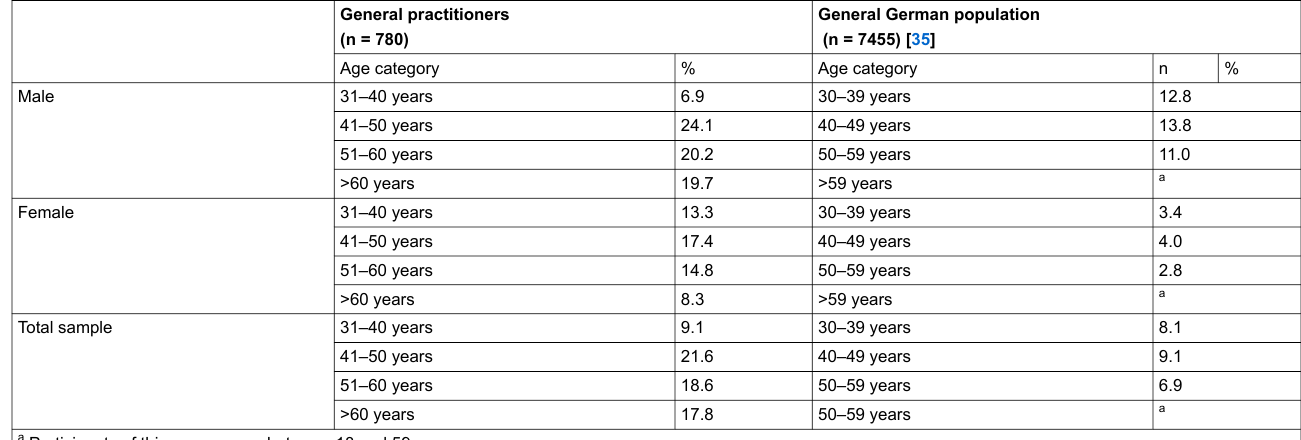
Table 5: Descriptive comparison of the relative frequency of lifetime alcohol use disorders (CAGE-G ≥2) in the sample of GPs and the general German population [35], stratified by age group (missings excluded). General practitioners (n =